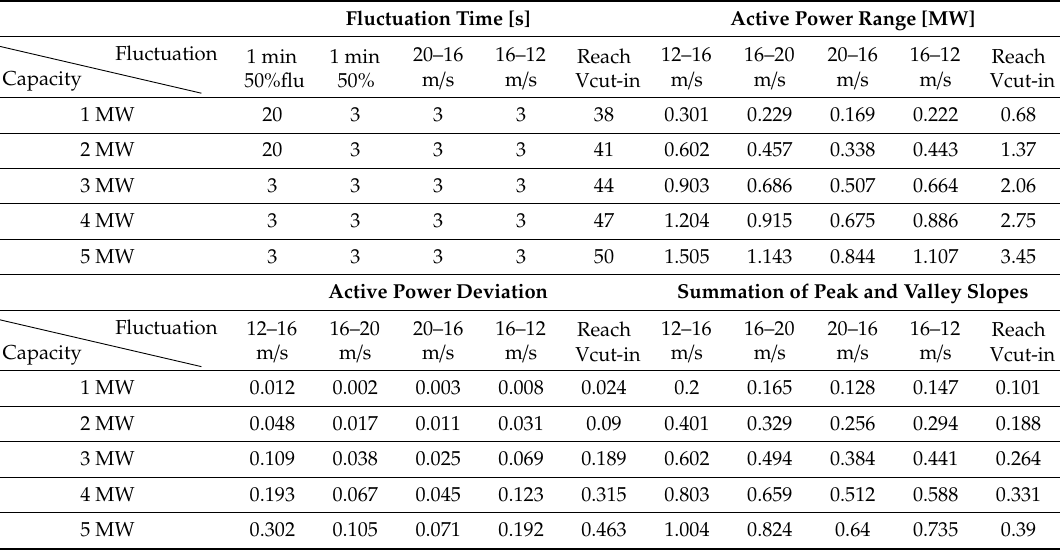
Figure 12. Output power of the WT-HT hybrid system with a WT installed capacity of 1–5 MW under five types of wind fluctuations. Table 4. Assessment results for a WT-HT hybrid